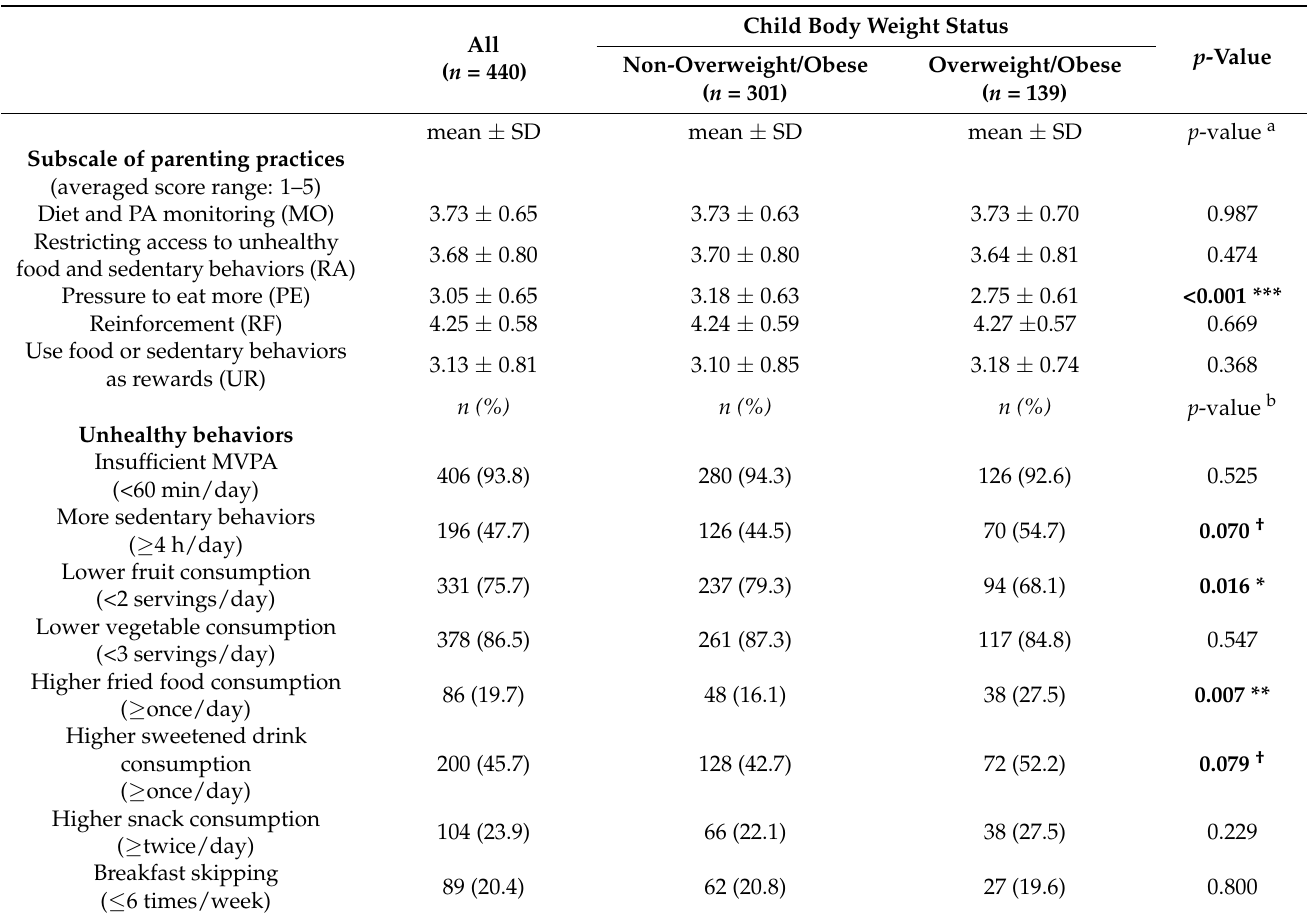
Table 2. Distribution of scores of parenting practices (mean ± SD) and unhealthy behaviors ( n and %) by child body weight